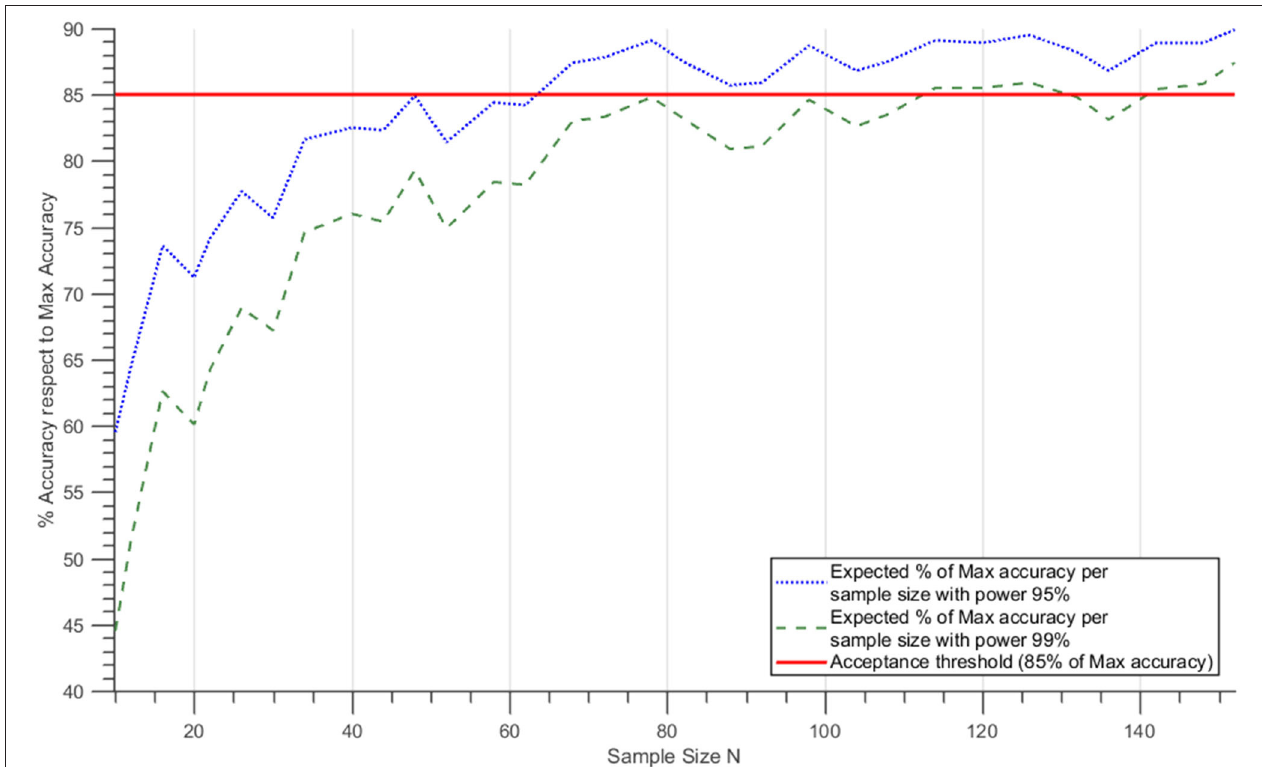
FIGURE 2 | Expected percentage of best accuracy as a function of sample size. Dotted blue and discontinuous green lines correspond to the mean % best accuracy reached for each sample size at statistical power 95 and 99%, respectively, assuming a normal distribution of the accuracy variation and estimating the means and the standard deviation for each sample size. The red line shows the 85% Max accuracy level.